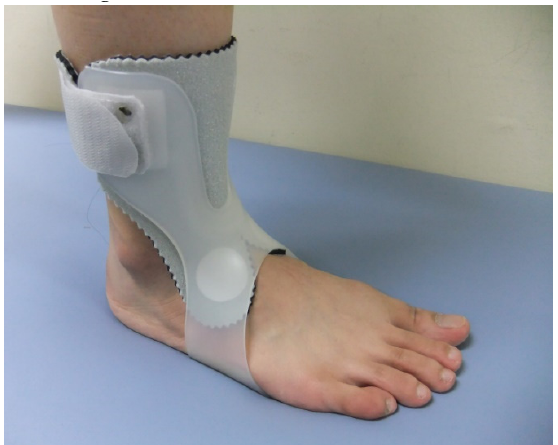
Figure 4. Lateral view of the UD-Flex ankle–foot orthosis.